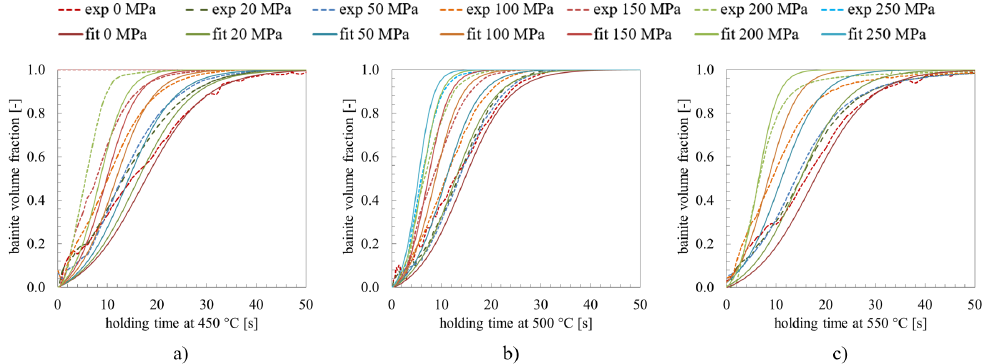
Figure 9. Comparison of simulated and experimental kinetics of the bainitic transformation in regard of applying different stresses for ( a ) 450°C, ( b ) 500°C and ( c ) 550°C (adapted from